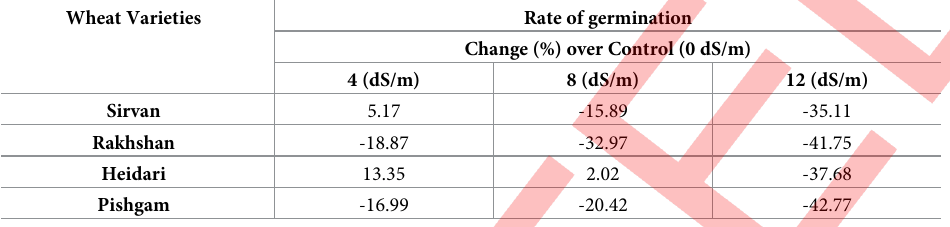
Table 2. Percentage change in rate of germination of different wheat varieties as influenced by variable salinity levels.